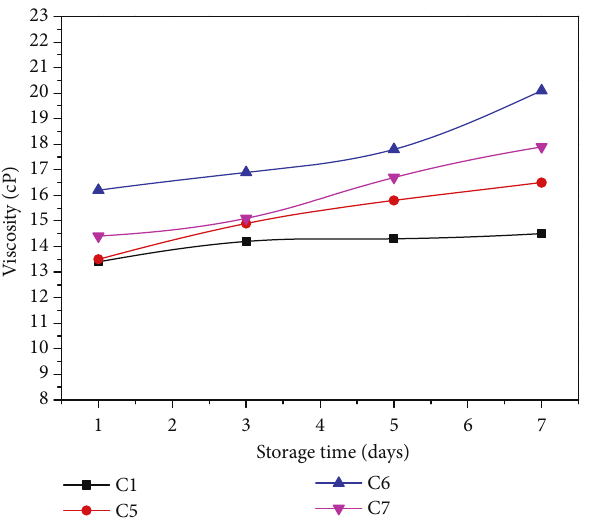
Figure 4: Viscosity changes of pre-vulcanized CNRL. Table 4: Stability of pre-vulcanized CNRL.